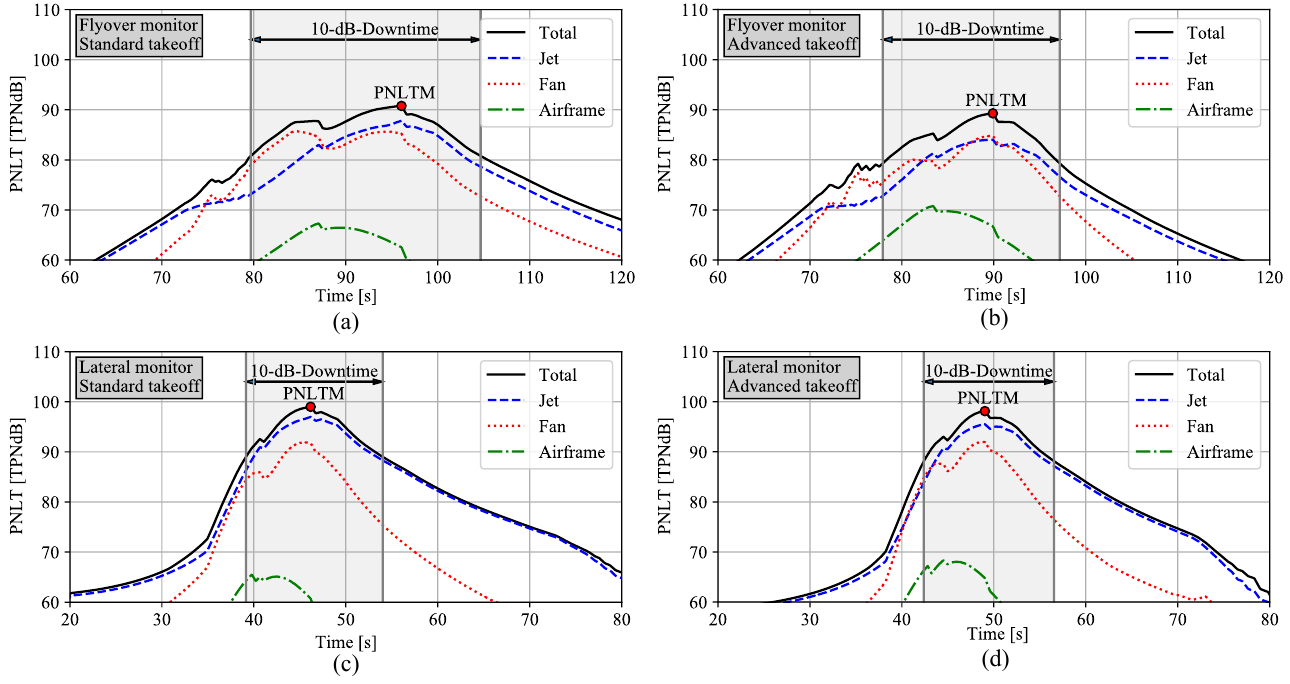
Figure 7. Calculated PNLT over time at flyover measurement point for standard ( a ) and advanced take-off ( b ) and at lateral measurement point standard ( c ) and advanced take-off ( d ). 10 dB-down time is filled grey and PNLTM is marked. 10 dB-down time represents the relevant time of the PNLT course for the calculation of the